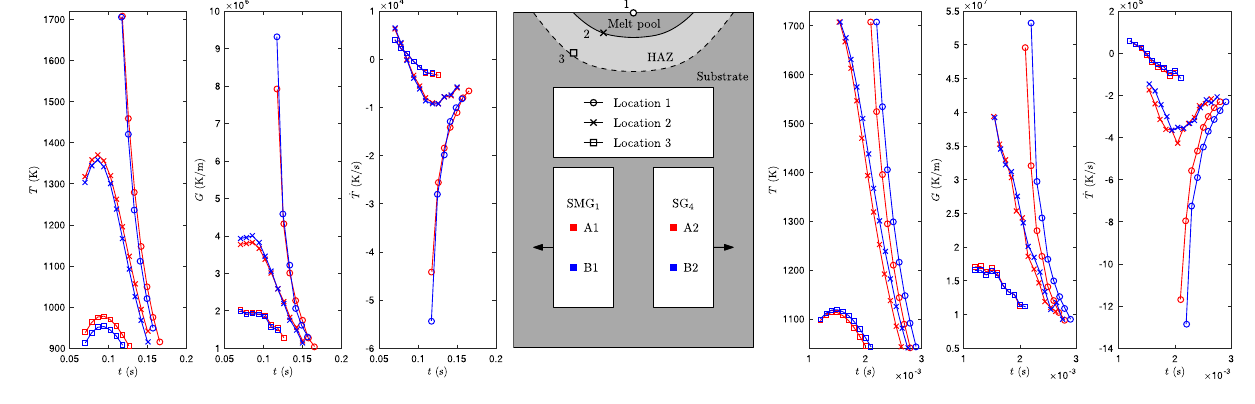
˙ T , for the SMG 1 (left)